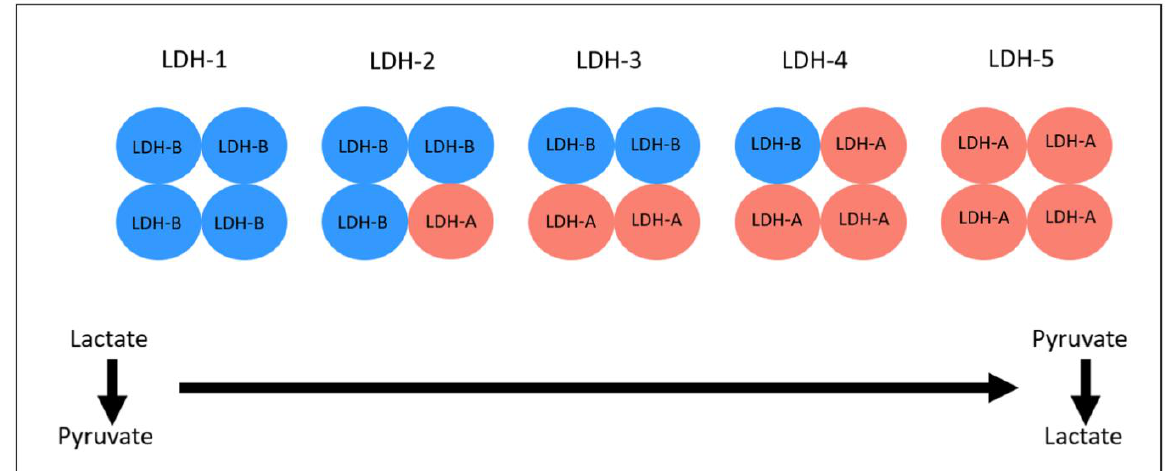
Figure 1. Lactate dehydrogenase (LDH) isotypes. LDH is a tetrameric enzyme composed of LDH-A and LDH-B subunits. Five isoforms exist: LDH-1 (4B), LDH-2 (3B1A), LDH-3 (2B2A), LDH-4 (1B3A) and LDH-5 (4A). As the number of LDH-A subunits increases (LDH-4 and LDH-5), the LDH isoenzyme becomes more efficient in catalyzing the conversion of pyruvate to lactate, thereby facilitating glycolysis. In contrast, isoforms predominantly consisting of LDH-B (LDH-1 and LDH-2) preferentially catalyze the reverse reaction.